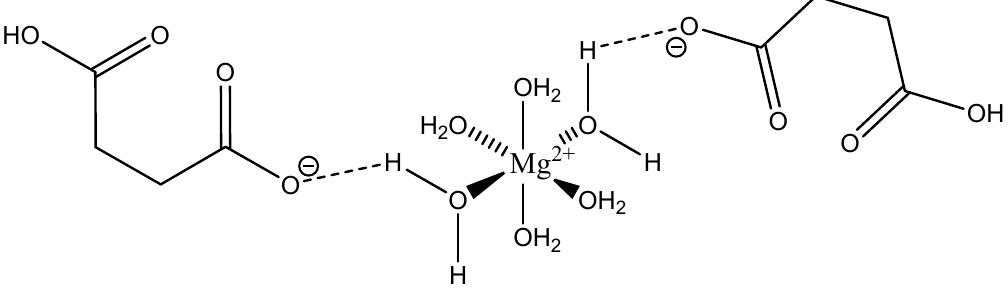
Figure 16. Structural Illustration of the magnesium bis (hydrogenmaleate) hexahydrate structure reported by Gupta et al. [103].